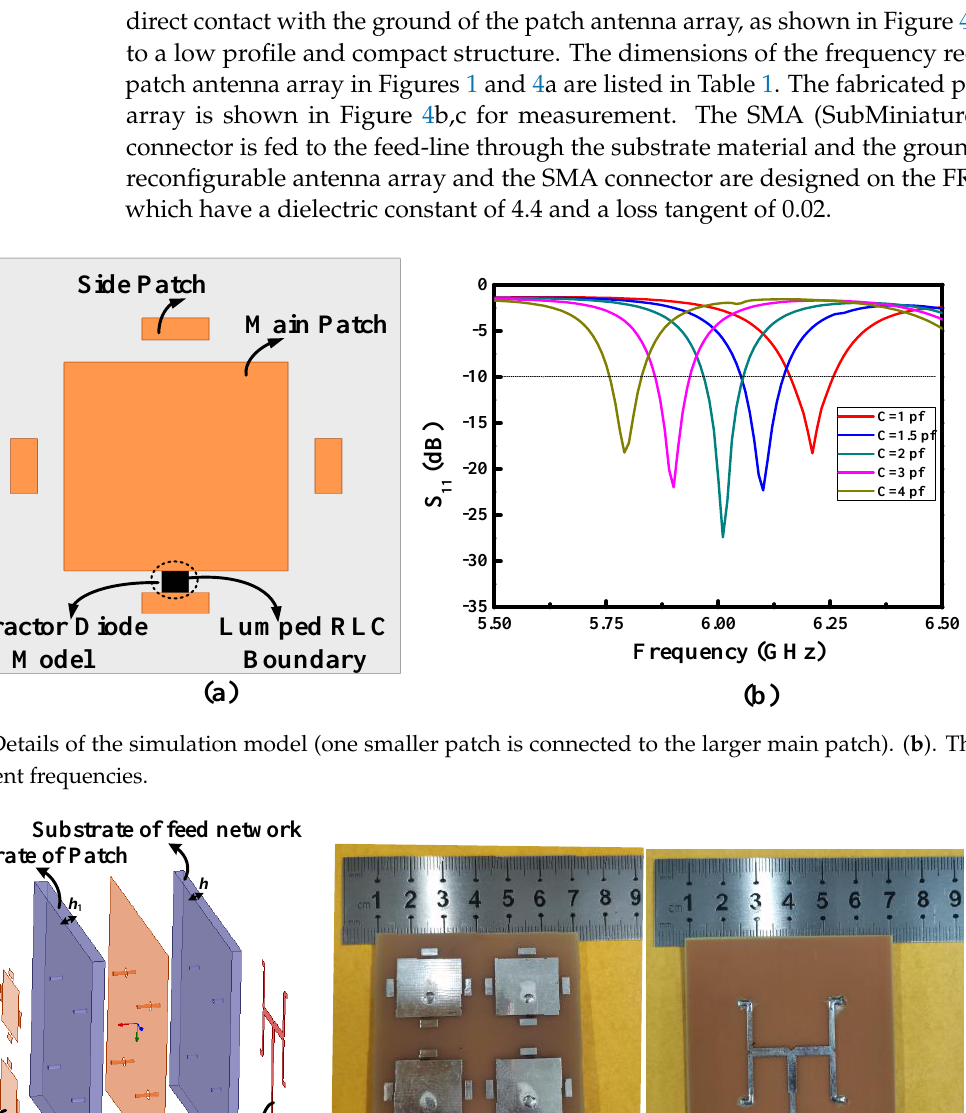
Figure 4. ( a ). Assembly schematic of antenna. ( b ) Top and ( c ) bottom views of the fabricated antenna. Table 1. Dimensions of the antenna array.